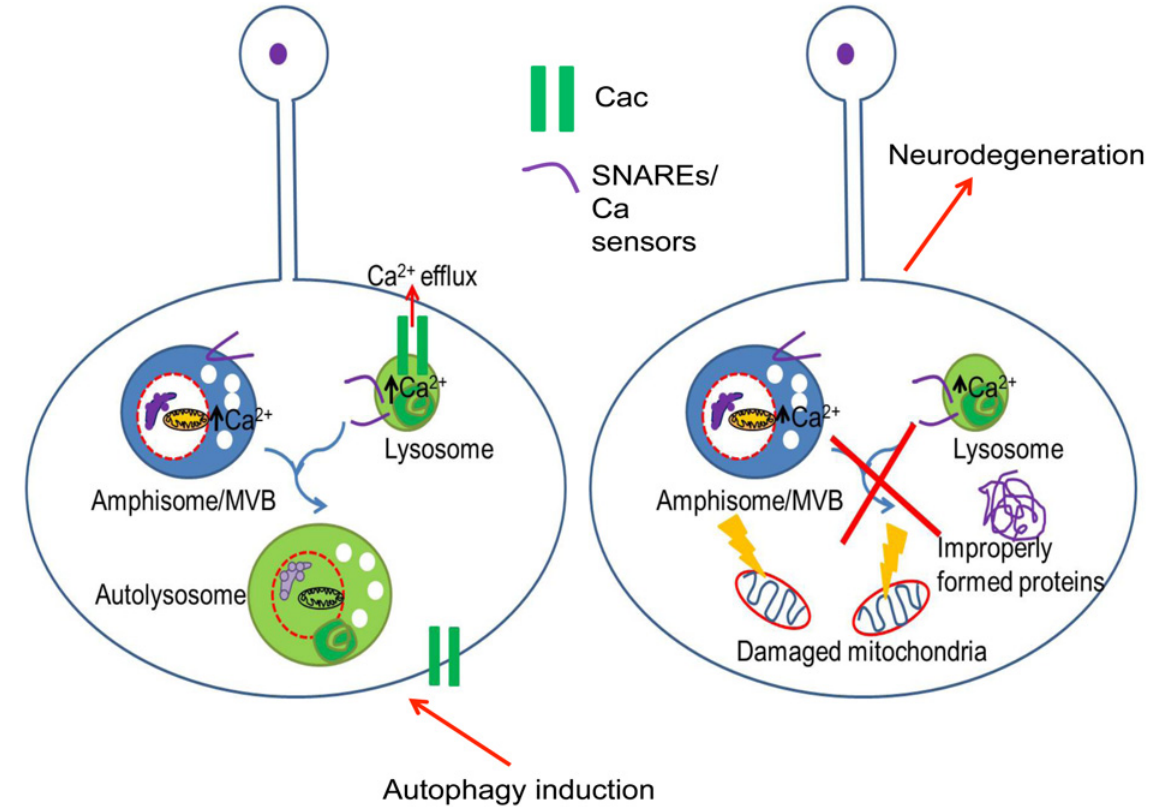
Fig 8. Cac is required on the lysosomes in neurons to promote lysosomal fusion. Cac and its accessory subunits are present on the lysosomes. Under normal conditions of activity requiring basal levels of autophagy, Cac allows for calcium efflux from endo/lysosomes to provide for SNARE-mediated fusion of autophagic vacuoles to lysosomes and subsequently efficient degradation of unwanted cellular material and to maintain neuronal homeostasis. In the absence of Cac, there is a block in the autophagic flux and lysosomal fusion, leading to an accumulation of fusion-primed autophagic vacuoles. This subsequently results in an accumulation of improperly formed proteins or damaged organelles, such as mitochondria in the neurons, and causes